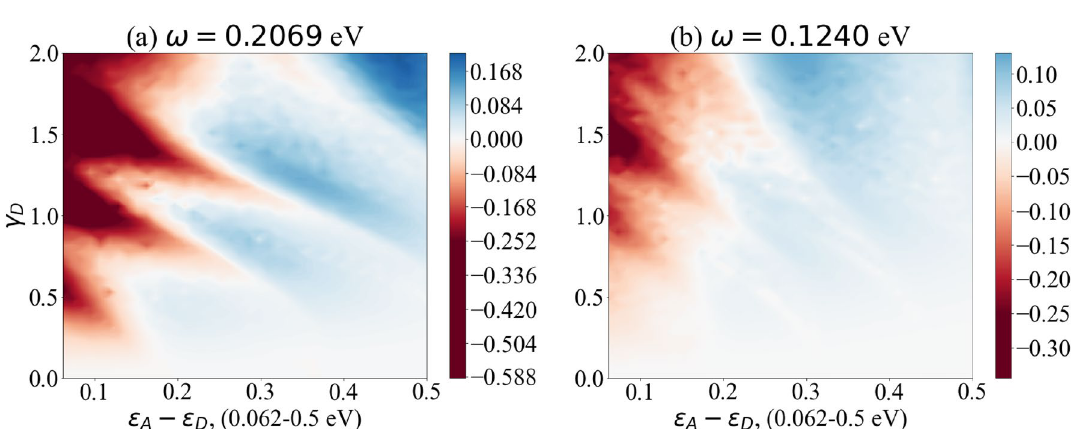
Figure 7. The difference between the maximum probability of transition with and without vibronic mode (cid:31) P Max as a function of the dimer detuning (ε A − ε D ) and the coupling strength between donor and vibronic mode (γ D ) . Comparison of highest and lowest vibronic frequencies ω = 0.2069 eV ( 1669 cm − 1 ) and ω = 0.1240 eV ( 1000 cm − 1 ) for very strong coupling to vibronic mode. Coupling strength with respect to frequency is plotted up to a maximum of 2 rather than 1, as in previous figures. The detuning between the dimer levels is plotted up to 0.5 eV rather than 0.2 eV as in previous